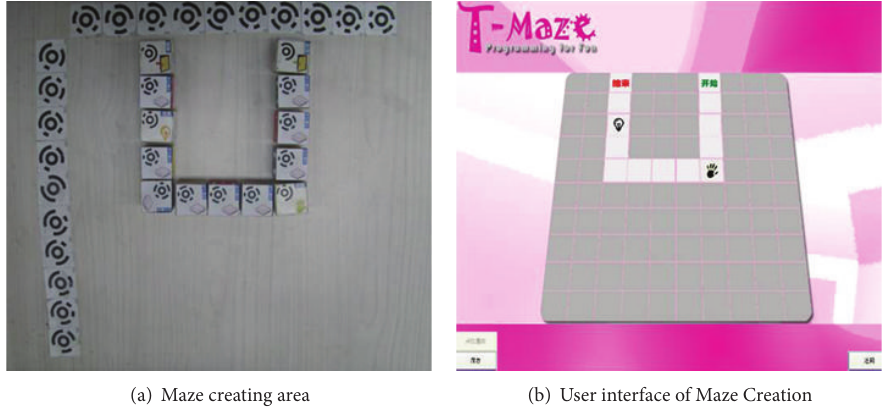
Figure 5: The creating area (a) and user interface (b) of Maze